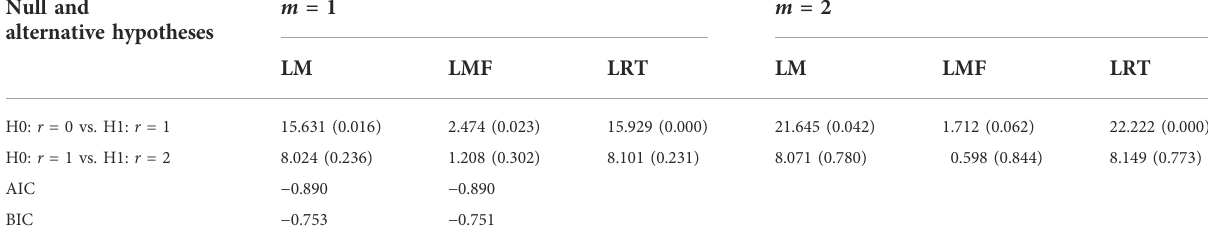
Note: p values are in parentheses, and m represents the dimension of location parameters.